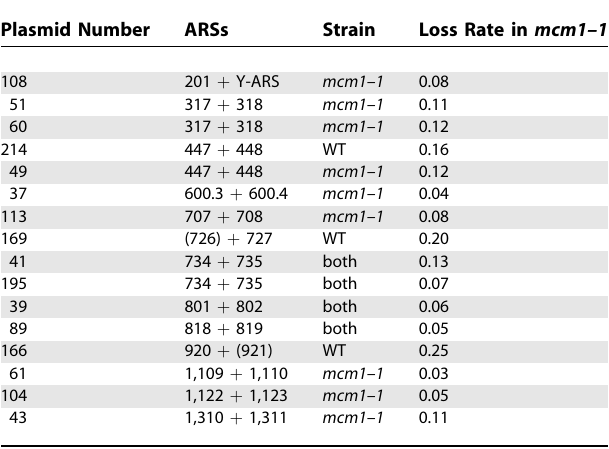
Table 2. Plasmids Containing Two Potential ARSs and Their Corresponding Loss Rates per Cell Division Plasmid